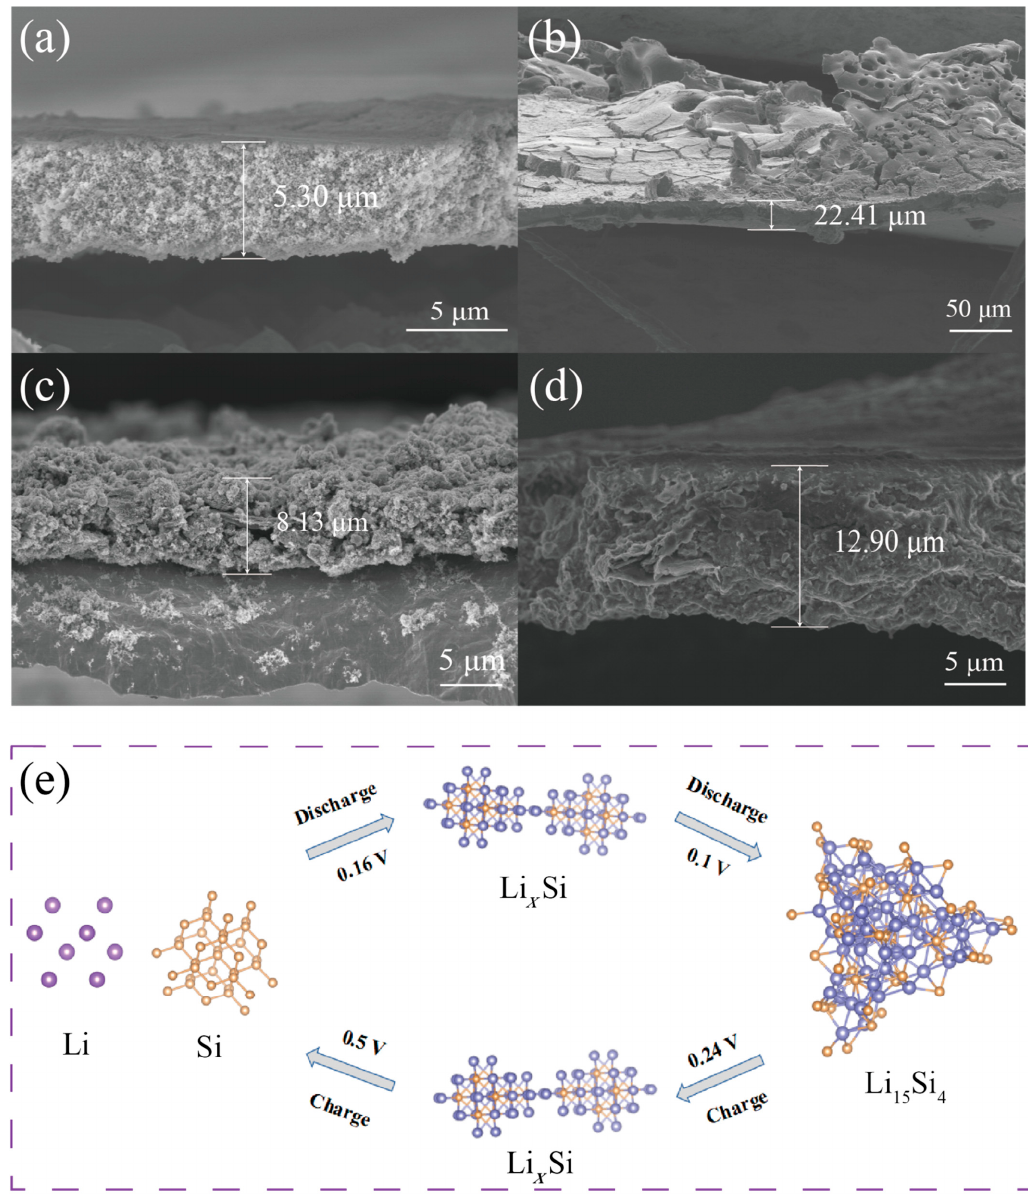
Figure 7. ( a , b ) Cross-sectional SEM images of Si before and after 150 cycles. ( c , d ) Cross-sectional SEM images of Si@MnO 2 @rGO-50°C before and after 150 cycles. ( e ) The mechanism of intercalation and deintercalation of lithium ions.